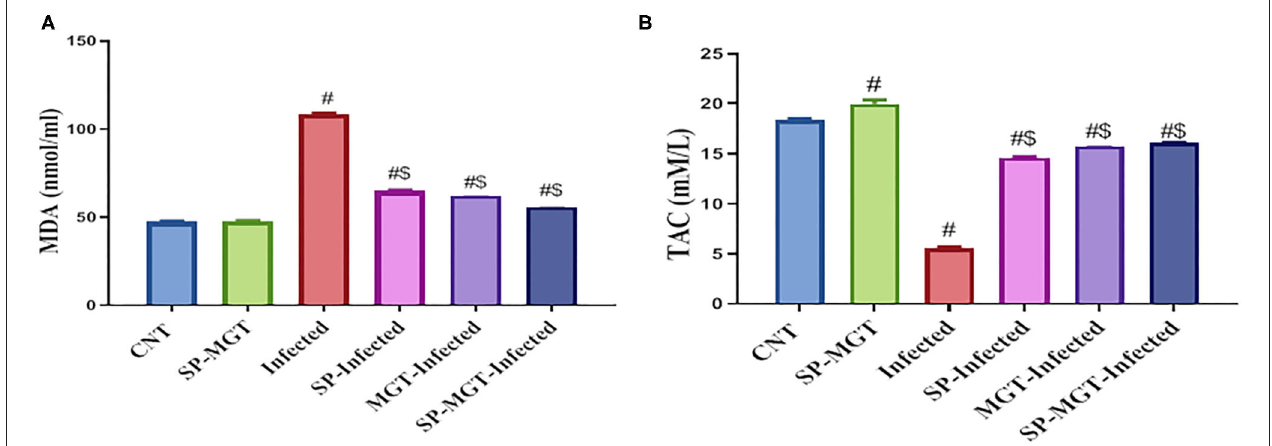
FIGURE 2 | Malondialdehyde (MDA; A ), and total antioxidant capacity (TAC; B ) levels in serum of mice in response to co-treatment with Spirulina platensis and/or matcha green tea in S. mansoni infected mice. Data were displayed as mean ± SEM ( n = 10/group). # or $ refers to the statistical significance at P < 0.05 against control and S. mansoni (infected) groups,